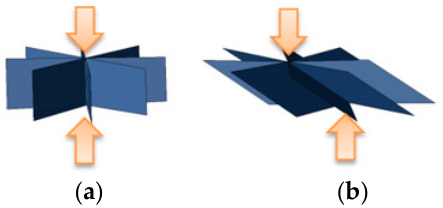
Figure 18. Differences in loading conditions of gap closing. ( a ) Ideal condition; ( b ) Distorted condition.